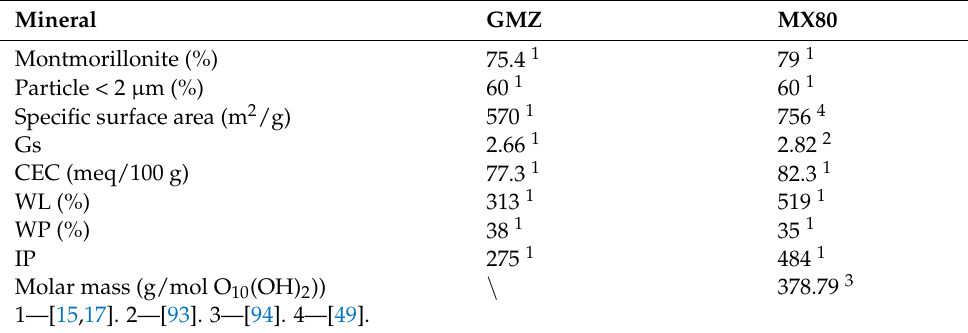
Table 3. The basic properties of GMZ and MX80 bentonite. Mineral GMZ MX80 Montmorillonite (%) 75.4 1 Particle < 2 µ m (%) Specific surface area (m 2